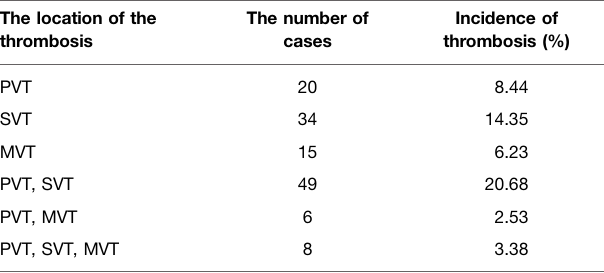
TABLE 2 | The incident of postoperative PVST formation.